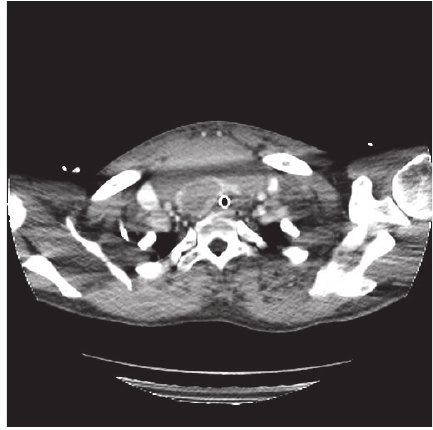
Figure 1: Arterial phase CT neck: axial view of neck haematoma demonstrating compression of the intubated trachea.